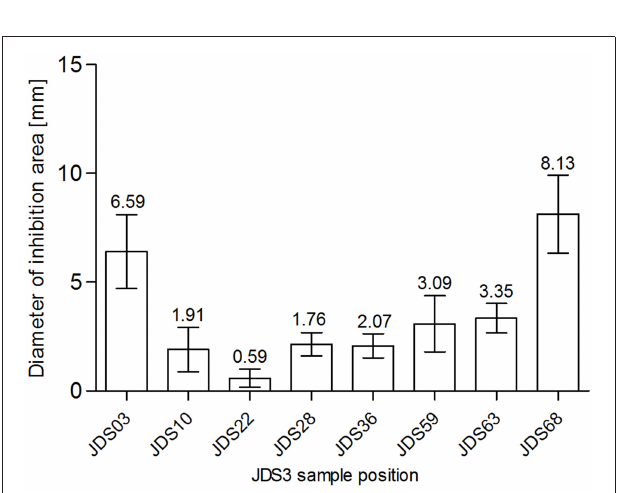
FIGURE 3 | Zone of inhibition diameters (mm) for SXT at the investigated sampling sites. Bars show mean values (values given on top of the bars, mm) and standard deviation errors bars (SD error bars) for each sampling